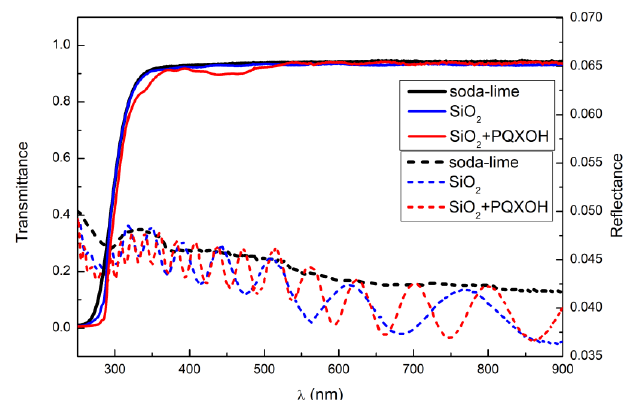
Figure 8. Transmission and reflection characteristics of the silica film and the silica film impregnated with PQXOH dye.